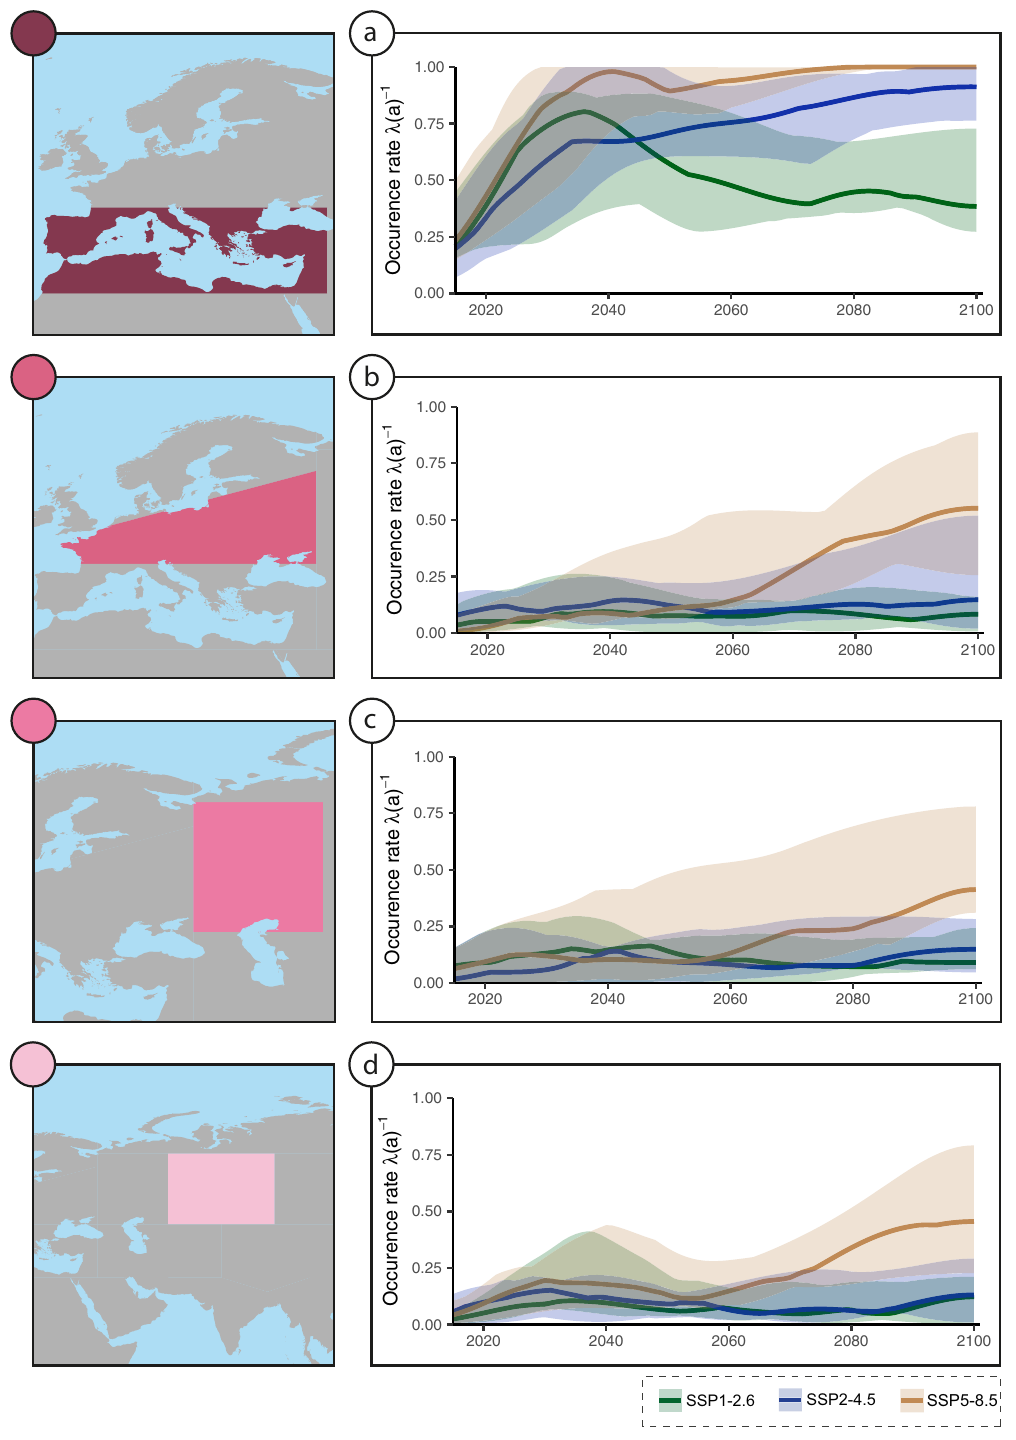
Fig. 7 Projected drought conditions for selected AR6 regions 23 in Europe and Asia. a – d Temporal evolution of occurrence rate of SPEI below − 1.5 under different future climate scenarios (SSP1-2.6, SSP2-4.5, SSP5-8.5). λ (a) − 1 = 1 indicates a SPEI value below − 1.5 can be observed every year. The SPEI is derived based on the baseline period of 1971 to 2100. The medians of the model ensemble from CMIP6 are highlighted. The 25 th and 75 th percentiles of the model ensemble for each scenario are indicated with shaded color around the